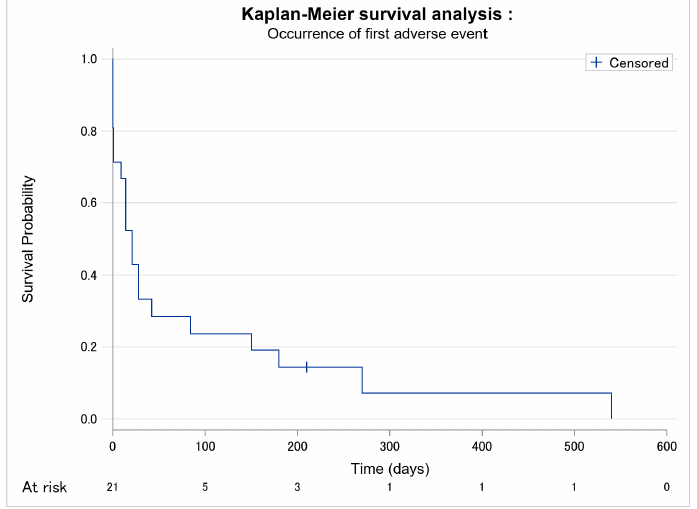
Figure 2. Kaplan–Meier survival analysis of occurrence of first all-grade adverse event among the 21 patients. No missing data. Table 4. Comparative table: before mogamulizumab-under mogamulizumab. p -value obtained using Fisher exact test for qualitative variables and Wilcoxon signed ranks test for quantitative variables.